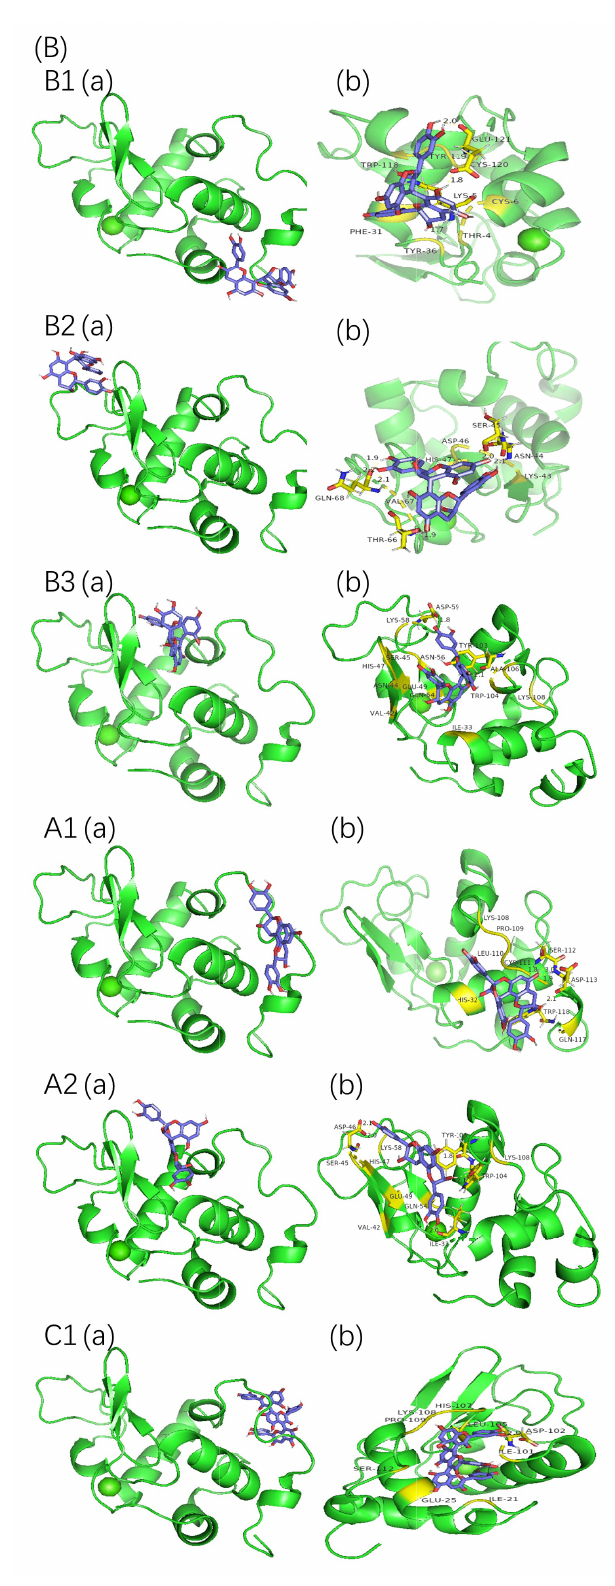
Figure 7. Molecular docking results of proanthocyanidins A1, A2, B1, B2, B3, and C1 with β -LG ( A ) or α -LA ( B ). ( a ) Best conformation for proanthocyanidins with proteins; ( b ) binding sites in detail. The interaction of amino acid residues with proanthocyanidins are shown in